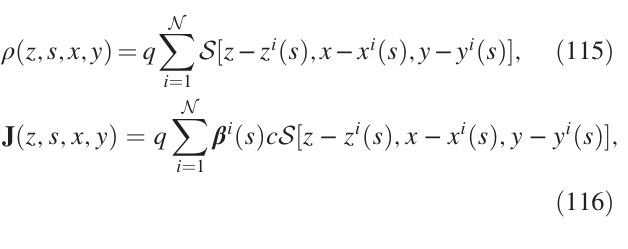
FIG. 24. The ratio r